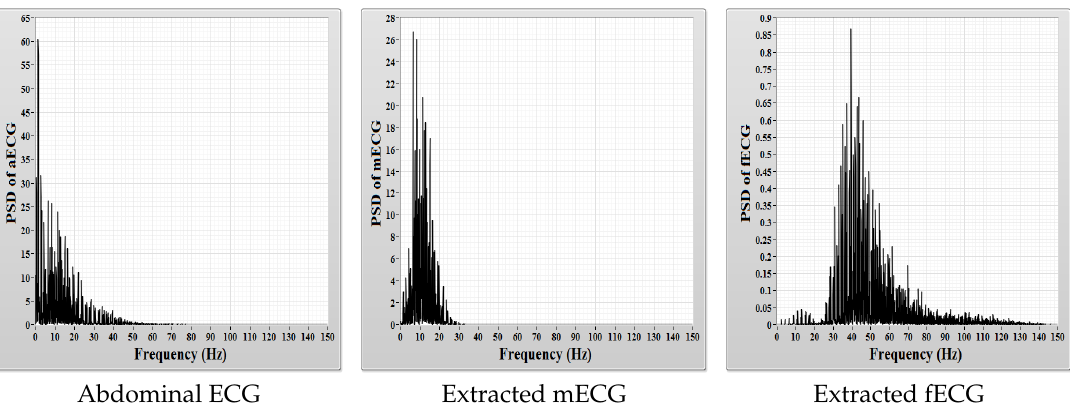
Figure 10. Comparison of the Power Spectral Density (PSD).